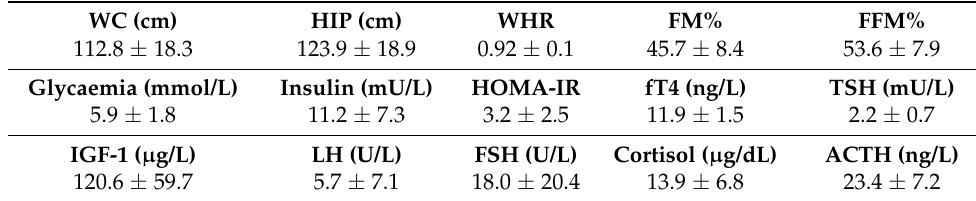
Table 1. Auxological and biochemical characteristics of the PWS study